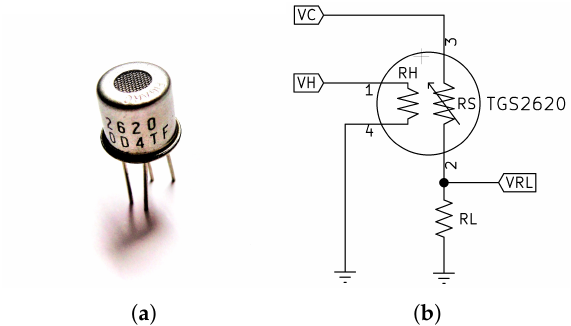
Figure 5. ( a ) A photograph of the TGS2620 sensor. ( b ) Measurement circuit recommended by